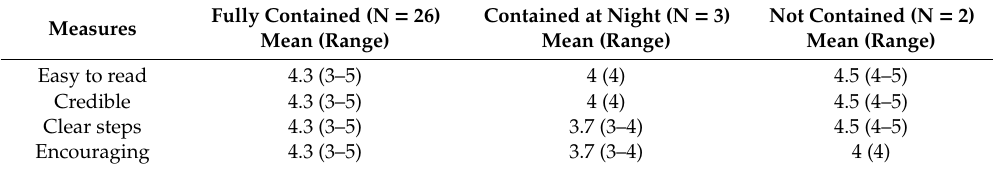
Table 2. Rating means and ranges of the content of the provided booklet by those participants who were keeping their cat fully contained (N = 26), contained at night only (N = 3) and not contained (N